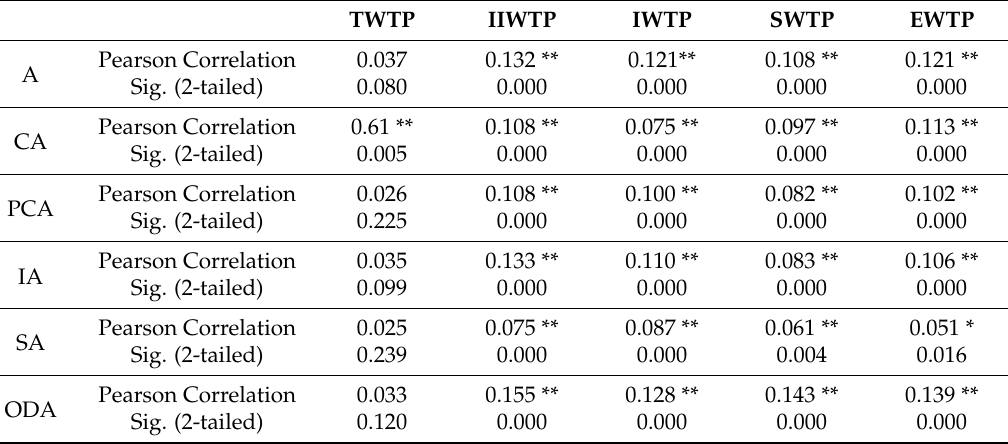
Table 6. Correlations between attention to occupational safety and health connotation and WTP (n =